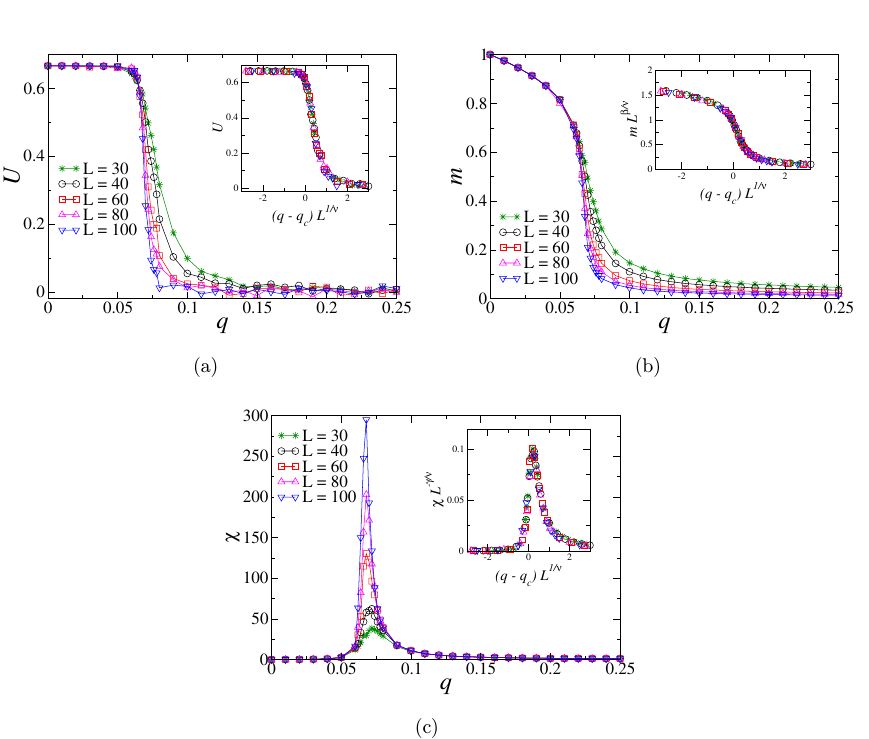
Fig. 1. Binder cumulant U (a), order parameter m (b) and susceptibility (cid:5) (c) as functions of the independence probability q for the symmetric case ( g ¼ 1 = 3 ) on 2D square lattices for di®erent lattice sizes L . In the inset, we exhibit the corresponding scaling plots. The estimated critical quantities are q c (cid:3) 0 : 065 , (cid:2) (cid:3) 0 : 125 , (cid:3) (cid:3) 1 : 75 and (cid:4) (cid:3) 1 : 0 . Results are averaged over 300, 200, 150, 120 and 100 samples for L ¼ 30 ; 40 ; 60 ; 80 and 100,